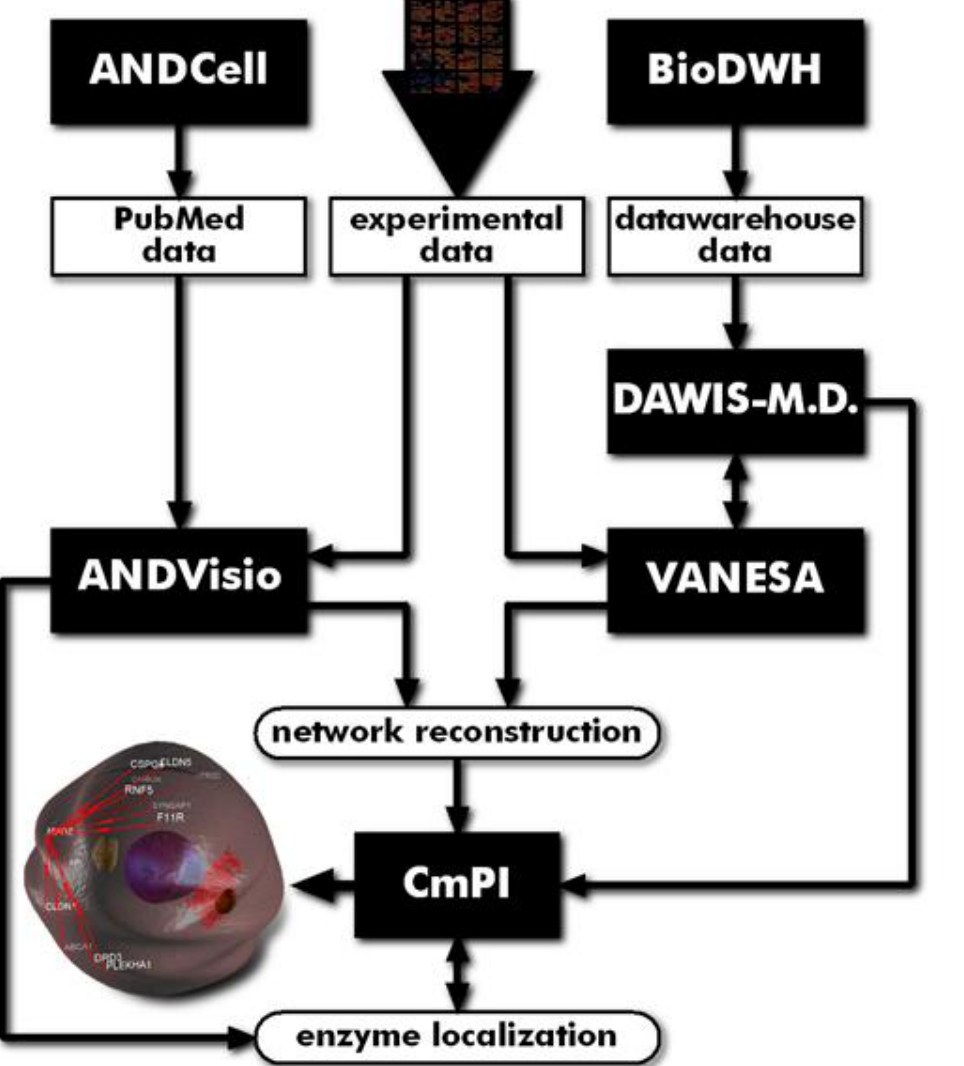
Figure 13: Knowledge generation by the combination of data from seven different